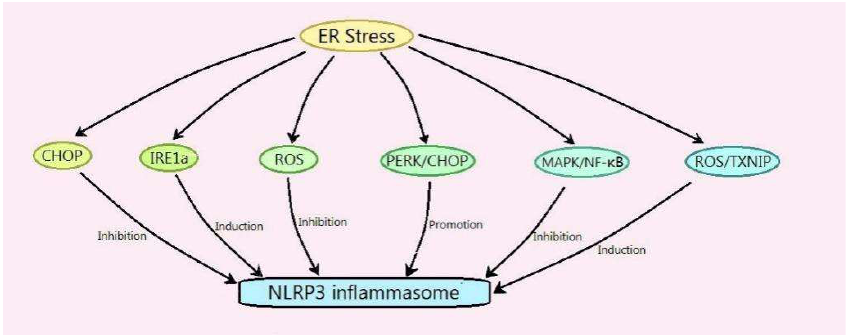
Figure 2. Mechanism of endoplasmic reticulum stress regulating the NLRP3 inflammasome in liver disorders.